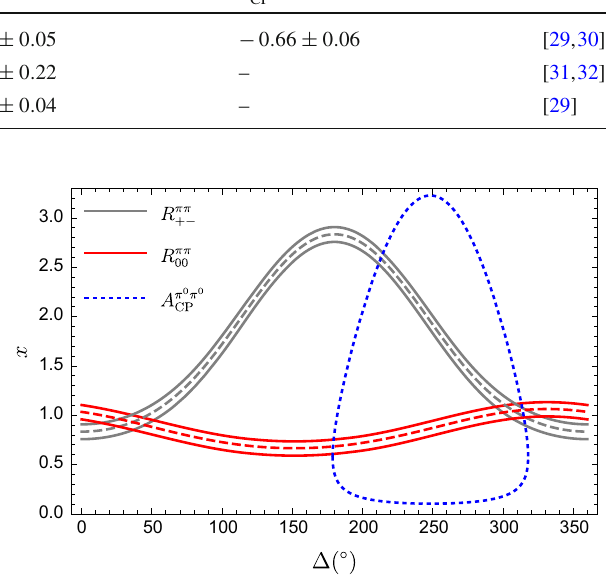
Fig. 2 Determination of x and (cid:4) from the current data for the ratios R ππ +− and R ππ . The two-fold ambiguity can be resolved through the 00 , where the current experimental central direct CP asymmetry A π 0 π 0 CP value results in the dotted blue line respectively,